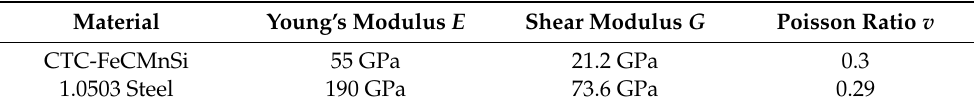
Table 2. Thermal and mechanical properties of the coating and substrate